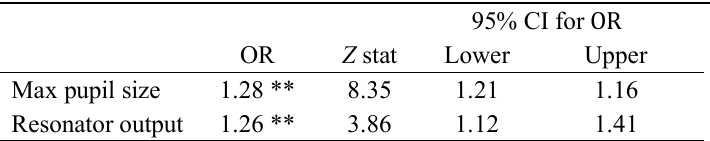
Table 3. Generalized linear mixed-effects logistic regression model with dependent variable hit (1) or miss